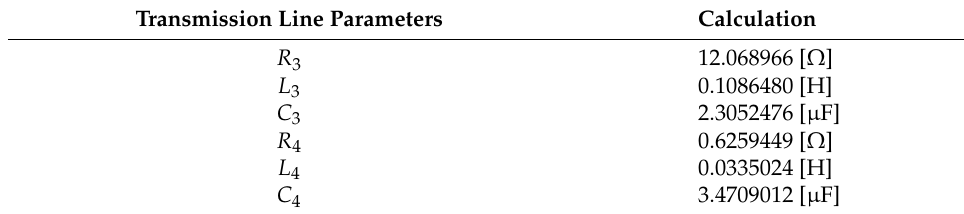
Table 6. Proposed model calculated parameters for Z 12 , Z 13 , and Z 23